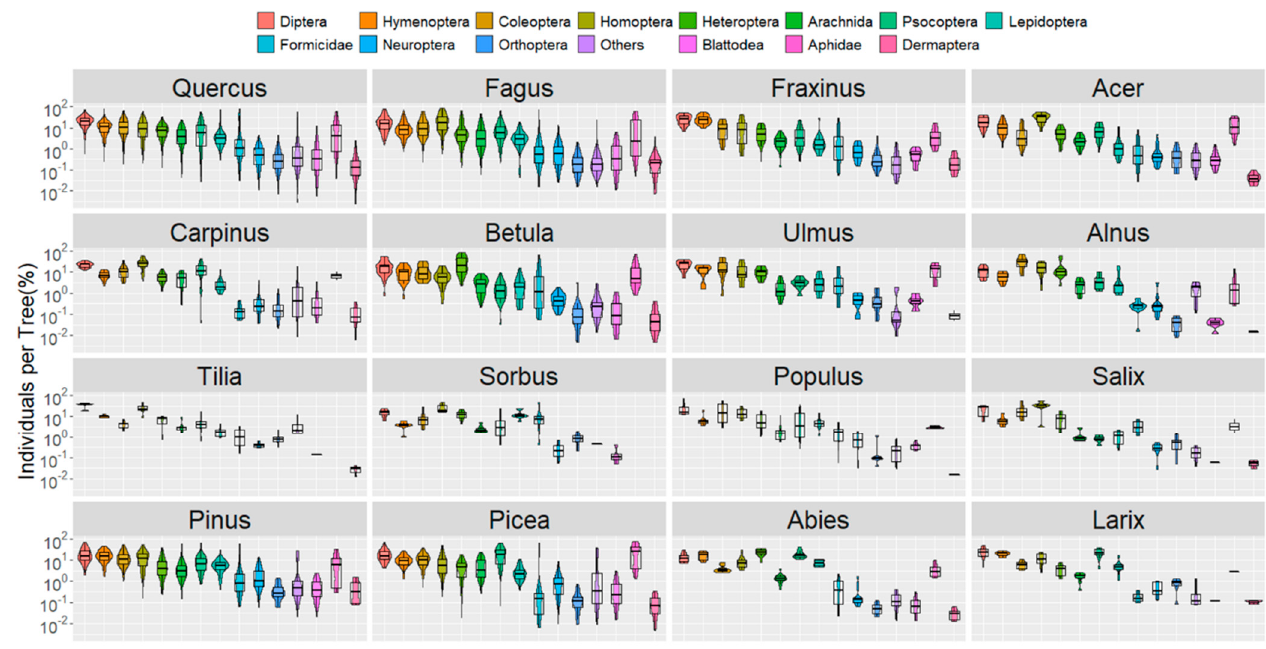
Figure 2. Violin plots with overlayed boxplots show how much arthropod taxa contribute to the canopy communities in the tree genera investigated. Compact violins indicate low variance in numbers, while extended violins show high betweensample variability. Tree genera are sorted according to the number of foggings; taxa are sorted according to the median. Quercus and Pinus were used as a reference for deciduous and coniferous trees, respectively. Two trees fogged in only one individual ( Malus and Pyrus ) are not displayed.